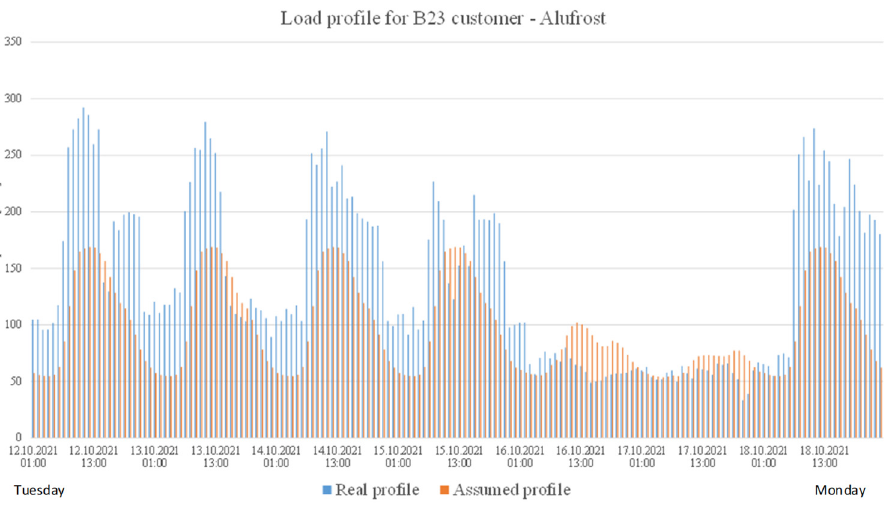
Figure 4. Comparison between the assumed B23 profile for the metallurgy company and real measurements.